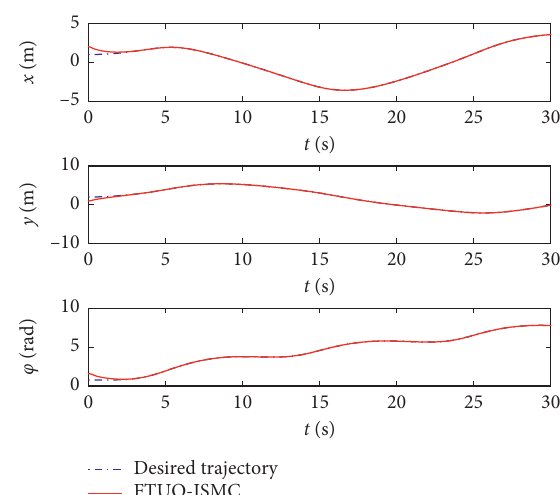
Figure 12: External disturbances and their estimations on FTDO- ISMC.